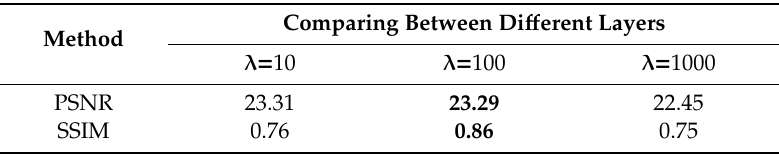
Figure 22. Generated images from extracting different layers in VGG16. First row uses low layers, second row combines low layers and high layer, and last row uses high layers. Table 8. PSNR and SSIM of di ff erent lambda on Kohler